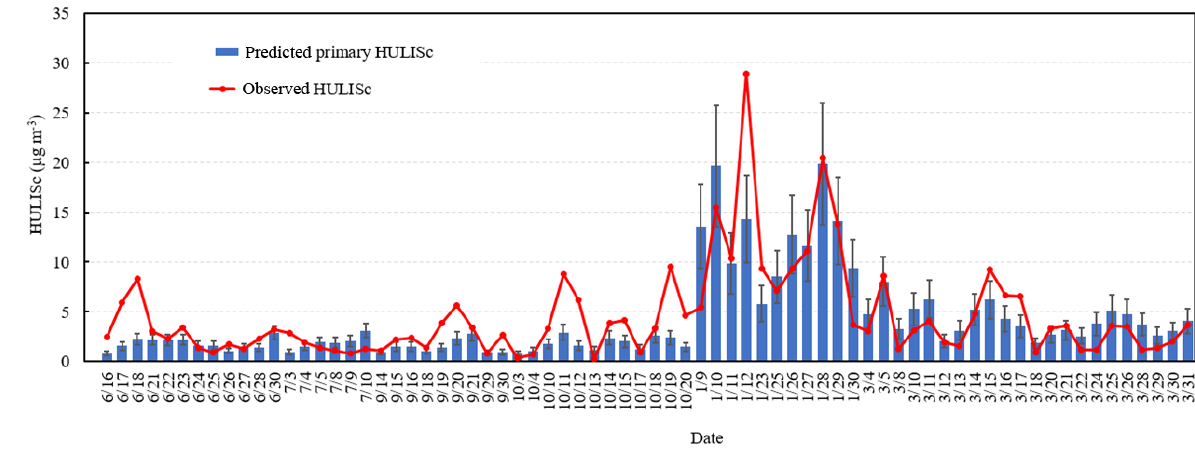
Figure 3. Predicted primary HULISc and observed HULISc concentrations on the days with relatively good primary PM 2 . 5 model perfor- mance. The error bar is the standard deviation of prediction, which is calculated as described in Text S3.1 in the Supplement. Table 3. Average and seasonal contribution percentages of various sources to ambient HULIS concentrations in Beijing (%). Residential Residential Transportation Industries Biomass open Secondary biofuel burning coal burning burning process Annual 47 . 1 ± 6 . 5 15 . 1 ± 2 . 9 2 . 0 ± 0 . 3 1 . 3 ± 0 . 3 1 . 7 ± 0 . 5 38 . 9 ± 9 . 1 Summer 29 . 2 ± 6 . 5 9 . 4 ± 2 . 7 3 . 9 ± 1 . 1 2 . 9 ± 1 . 2 10 . 3 ± 3 . 7 50 . 2 ± 19 . 3 Autumn 24 . 8 ± 5 . 5 8 . 0 ± 2 . 3 2 . 7 ± 0 . 8 1 . 7 ± 0 . 8 63 . 2 ± 18 . 3 Winter 55 . 7 ± 14 . 1 17 . 9 ± 6 . 3 1 . 1 ± 0 . 4 30 . 3 ± 17 . 2 Spring 62 . 7 ± 12 . 8 20 . 1 ± 5 . 4 2 . 0 ± 0 . 5 1 . 2 ± 0 . 4 0 . 1 ± 0 . 1 25 . 4 ± 13 .